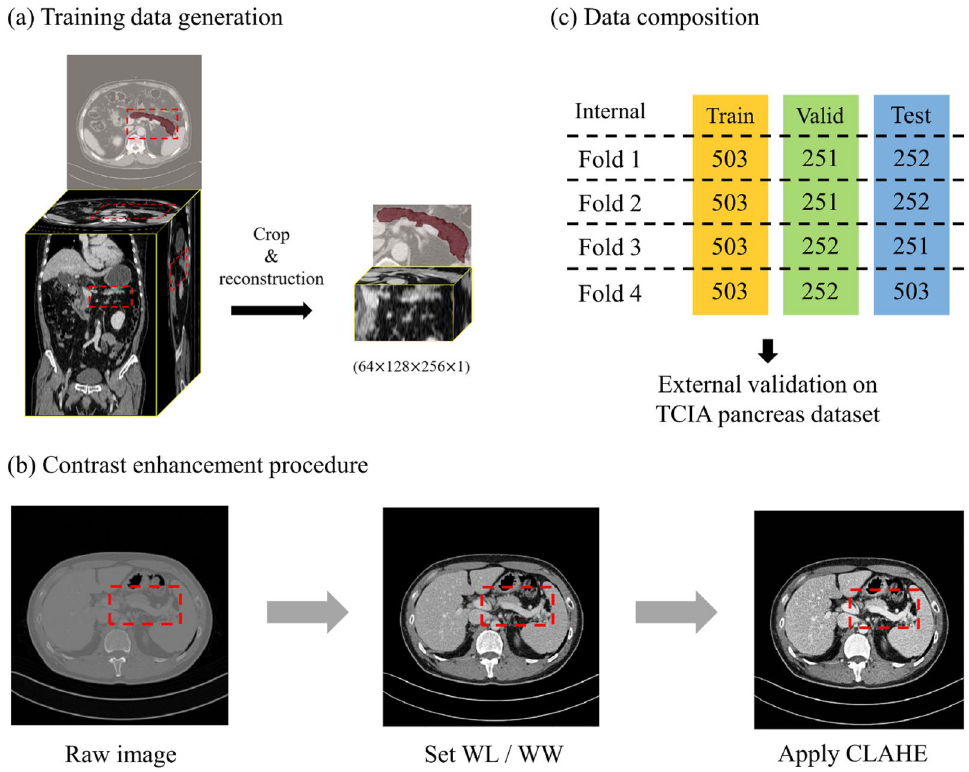
Figure 1. ( a ) Raw volume data were cropped and reconstructed for training data generation. ( b ) All data were divided into datasets that consisted of almost identical numbers of participants for cross validation. ( c ) A region of the pancreas was enhanced via CLAHE. Valid, validation; TCIA, the Cancer Imaging Archive; WL, window level; WW, window width; CLAHE, contrast-limited adaptive histogram equalization.